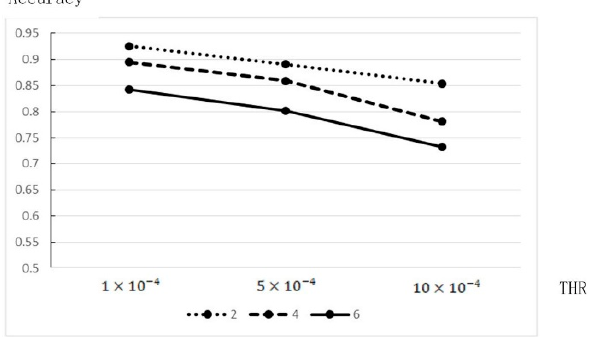
Figure 6. Recall ratios of the Mahalanobis distance detection under different settings.